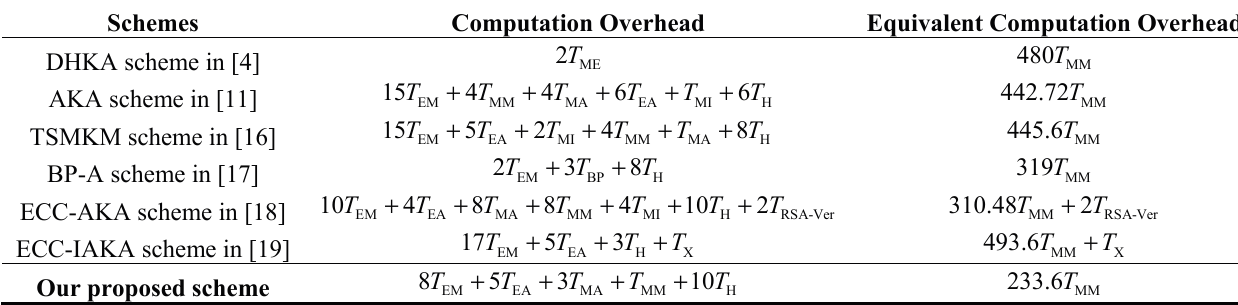
Table 6. Computation overhead of each